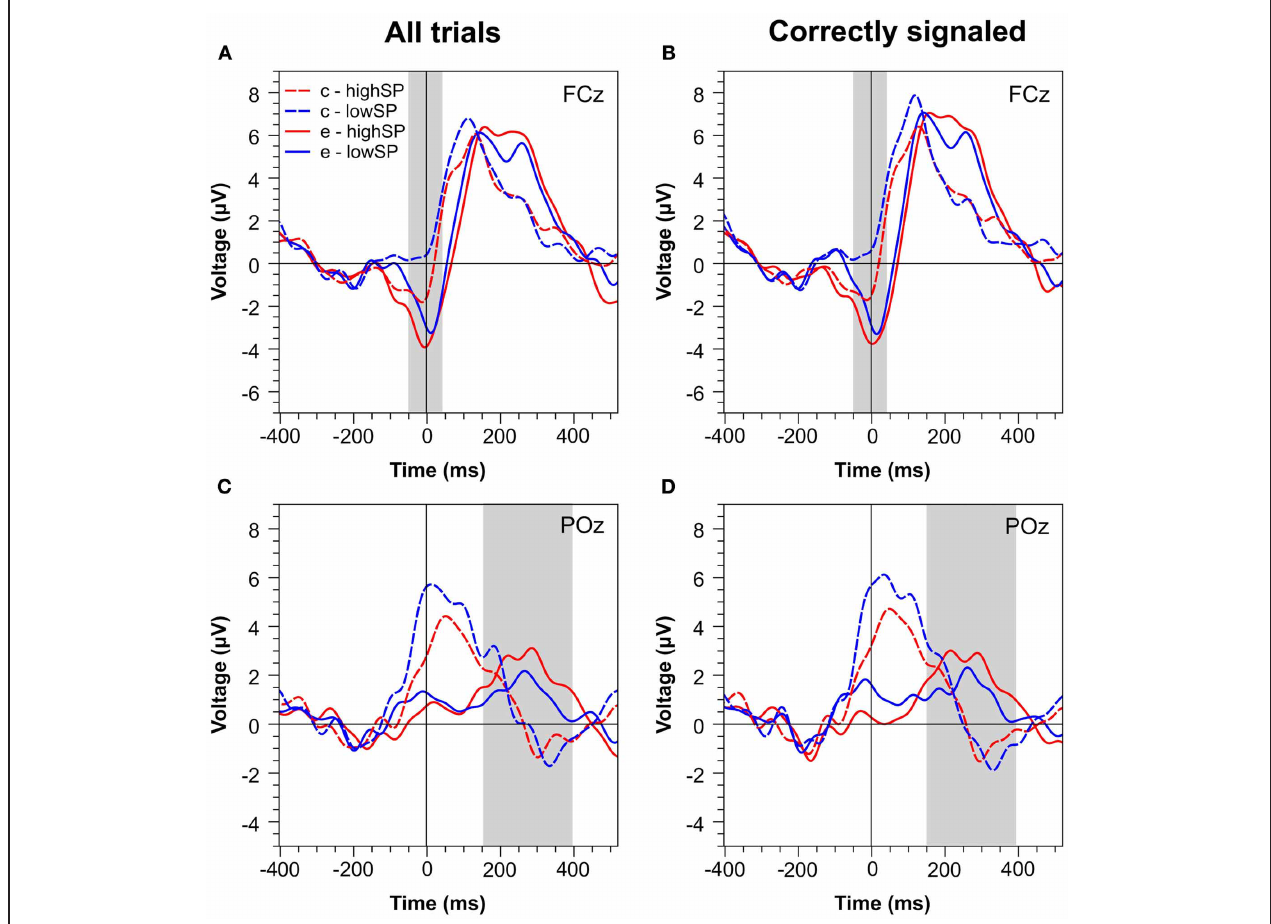
FIGURE 4 | Response-locked ERPs for RT matched data separately for the highSP and lowSP conditions. (A,C) Mean ERP waveforms at electrodes FCz and POz for all errors and correct responses. (B,D) Mean ERP